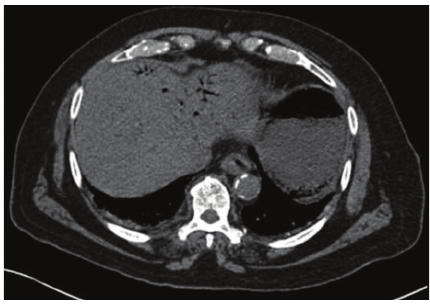
Figure 1: CT showing hepatic portal venous gas (Case 1).